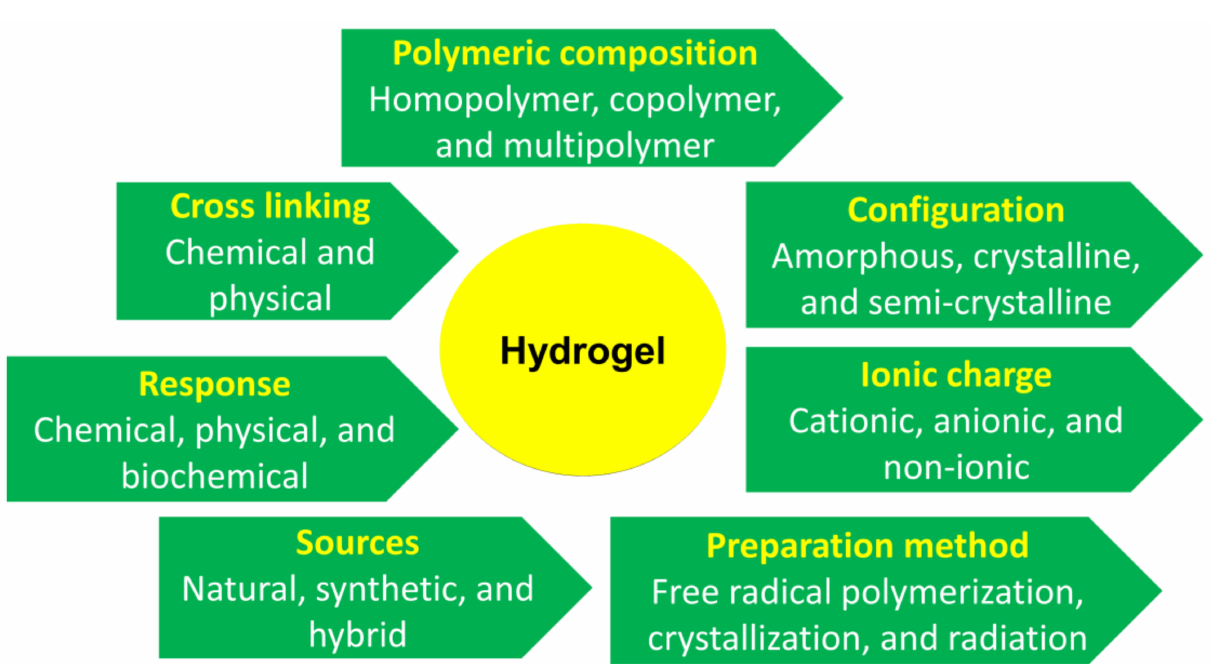
Figure 2. Classification of hydrogels. Figure 2 is adapted with permission (Copyright © 2022 Elsevier B.V., Amsterdam, The Netherlands) from Hasan et al.